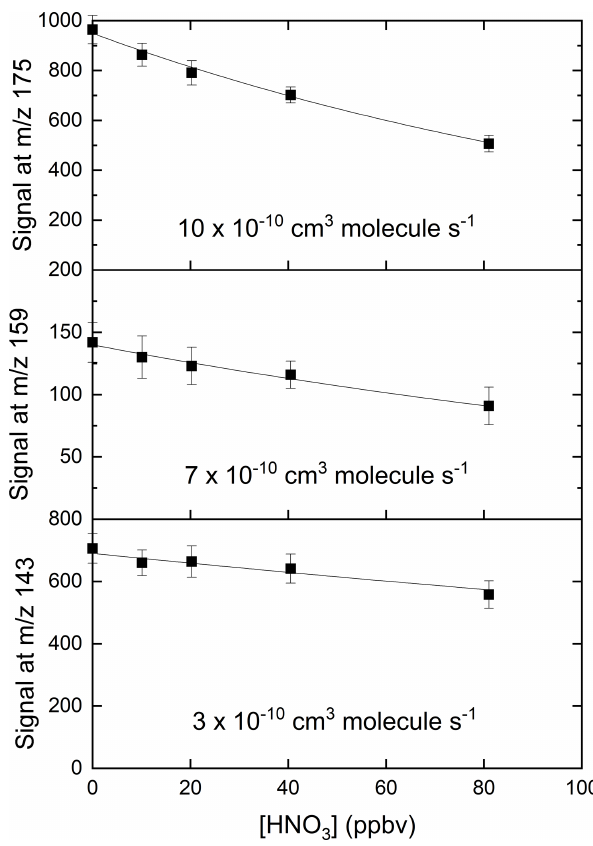
Figure 5. Relative changes in signals at m/z 143 (IO − ), m/z 159 (IO 2 − ) and m/z 175 (IO 3 − ) when adding up to 80ppbv of HNO 3 . The rate coefficients were calculated using a reaction time of 25 ms and should thus only be regarded as